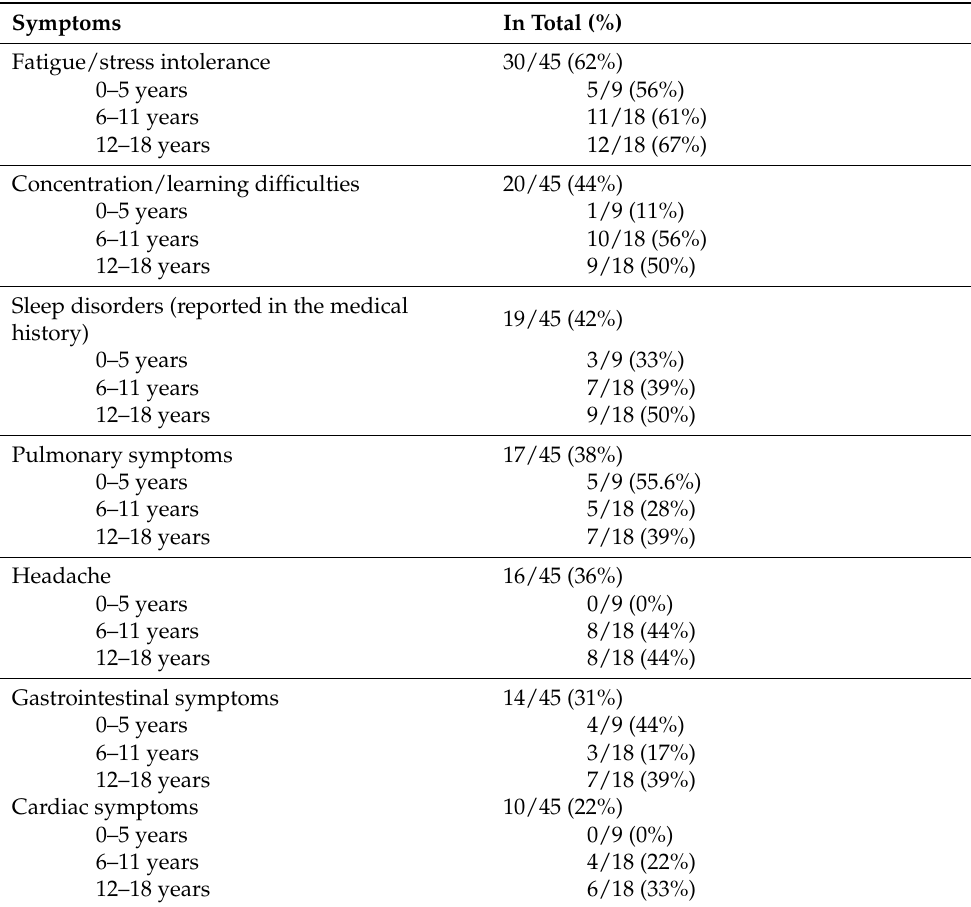
Table 3. Predominant symptoms at initial presentation; differentiation by